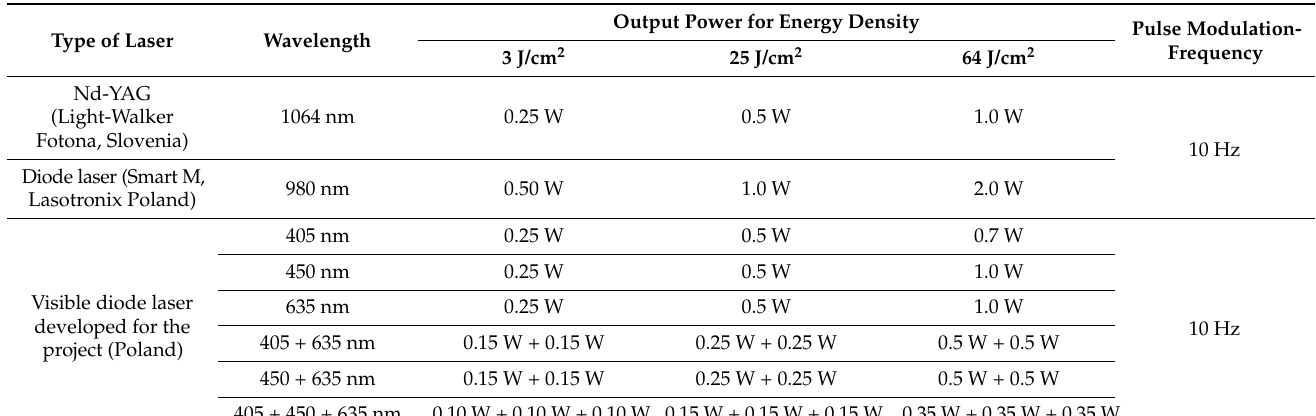
Table 1. Parameters of: Nd:YAG (LightWalker Fotona, Slovenia), 980 nm diode laser (Smart M, Lasotronix, Poland), and Visible laser developed for the project